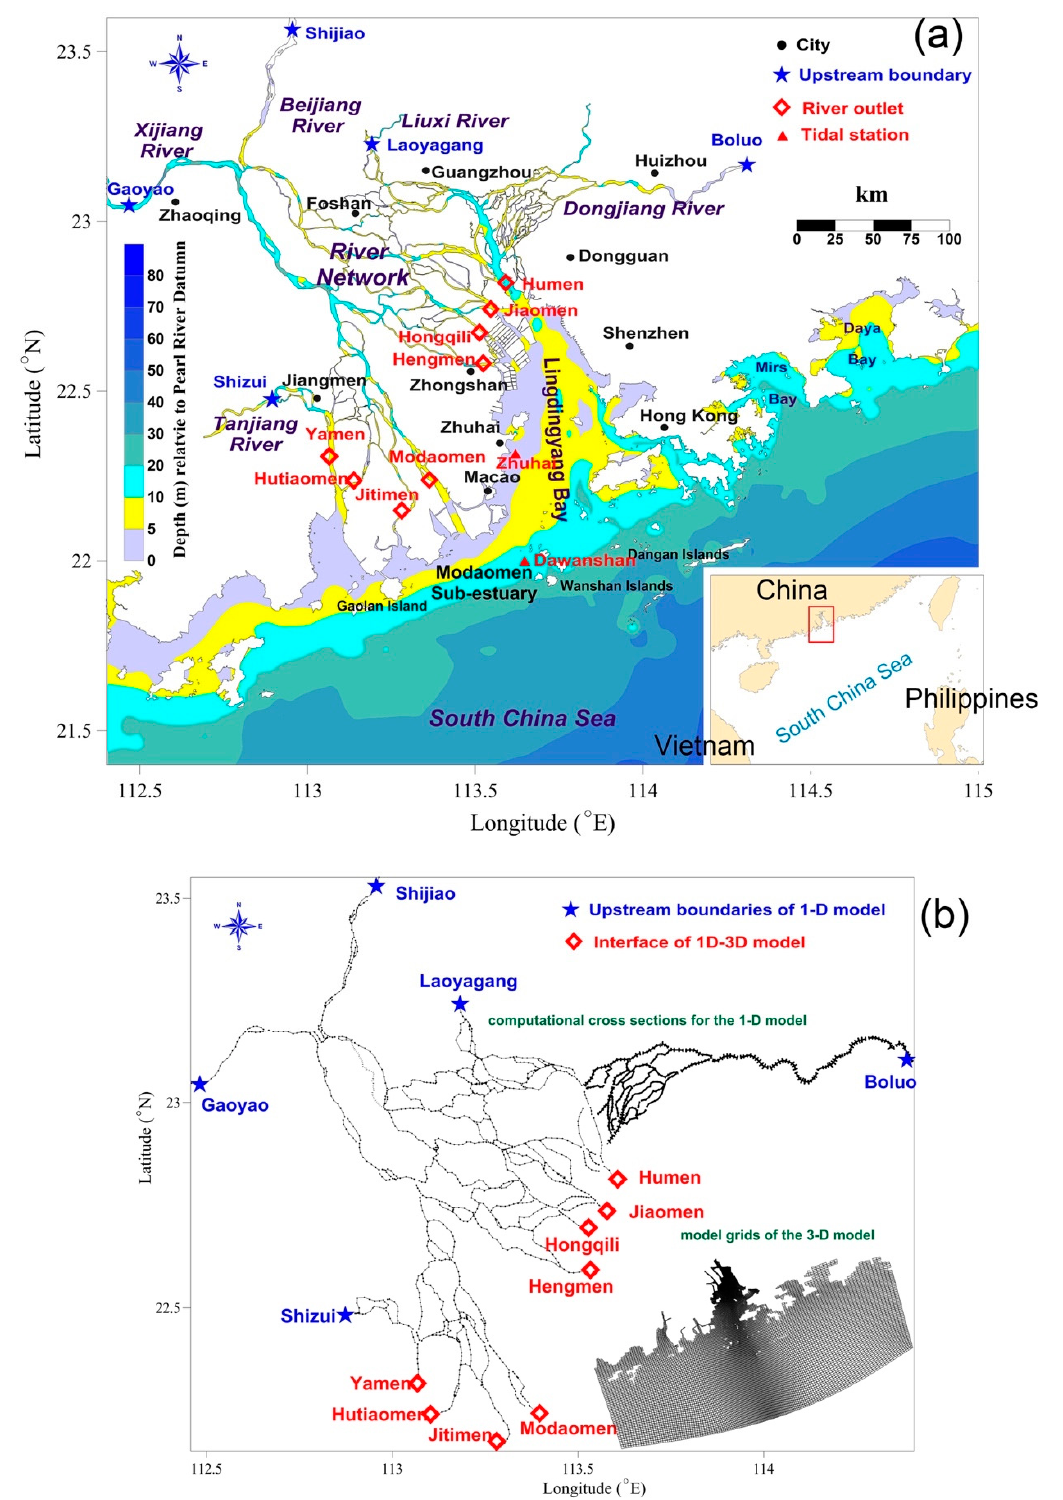
Figure 1. ( a ) Maps showing the Pearl River network and the Pearl River estuary. ( b ) Computational cross sections for the 1-D model and model grids of the 3-D model.